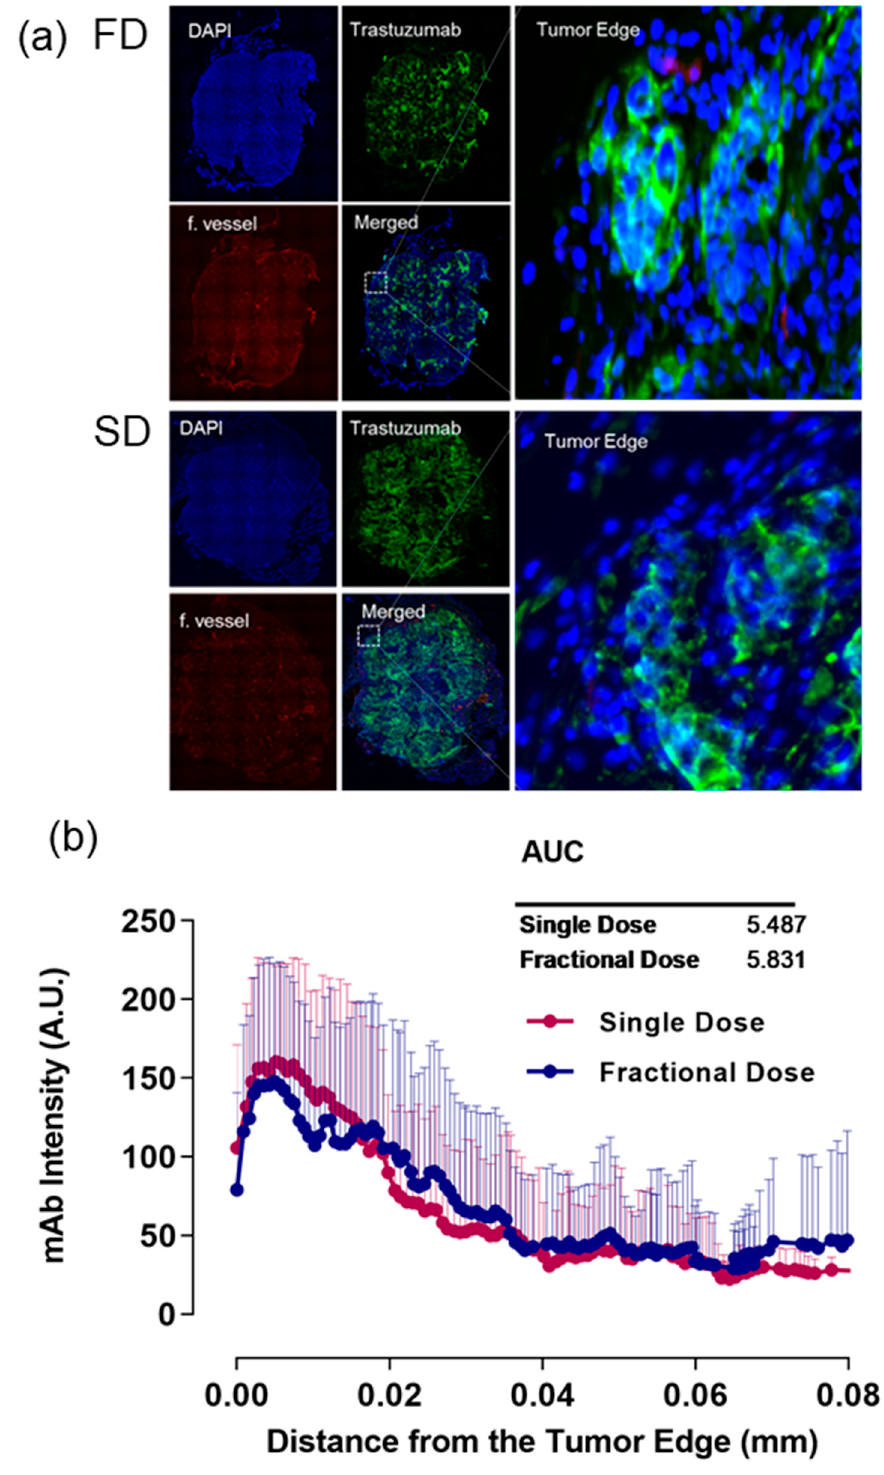
Figure 3. Representative images of SD (single dose) and FD (fractional dose). ( a ) DAPI in blue, TRZ (trastuzumab) intensity in green, functional vessel in red, merged images, and zoomed merged area near tumor edge. ( b ) Histogram plot shows line profiling comprising mean and standard deviation as error bars (above) of SD and FD with respective AUC values.